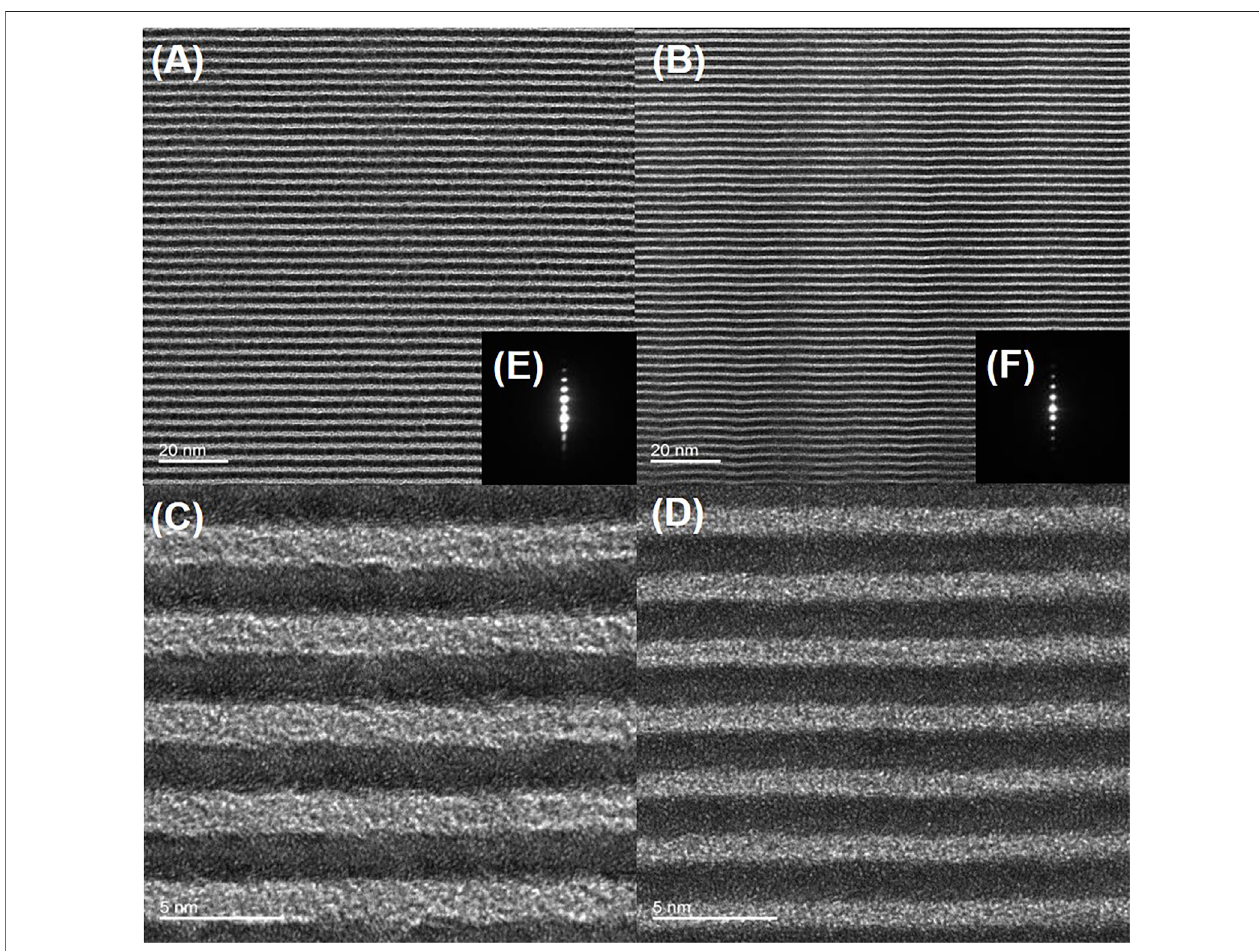
FIGURE 2 | Transmission electron microscopy (TEM) and selected area electron diffraction (SAED) images of the NiV/B 4 C multilayers fabricated with background pressures of 4 × 10 − 4 Pa (A,C,E) and 4 × 10 − 5 Pa (B,D,F) .